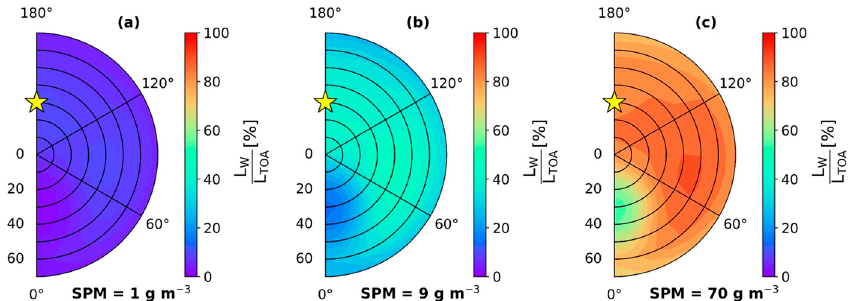
Figure 4. Polar diagram of the ratio L w / L TOA (in %) at 620 nm for various oceanic